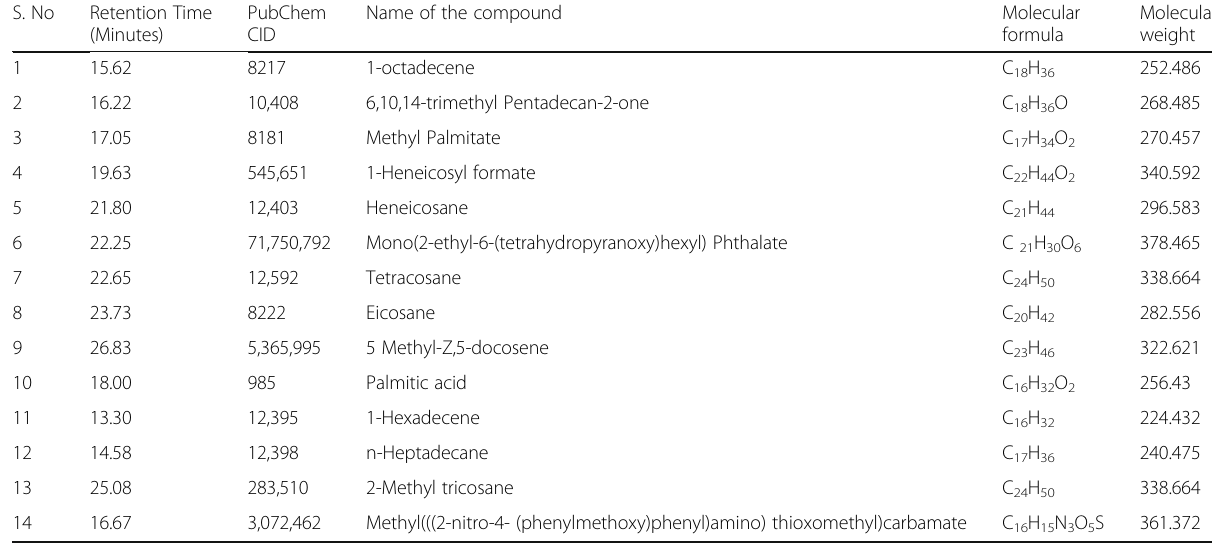
Table 2 GC-MS profile of G.acerosa ethyl acetate extract S. No Retention Time (Minutes)